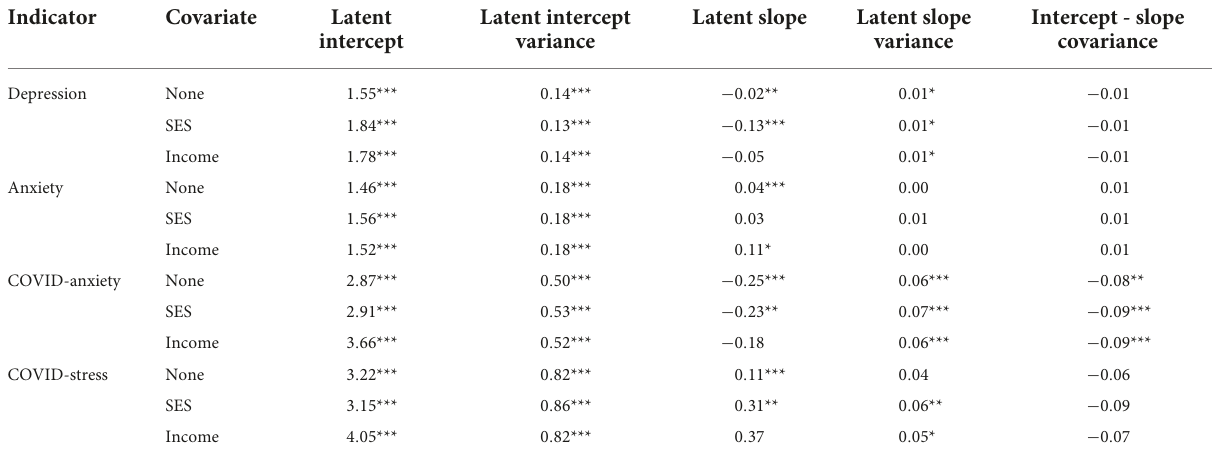
TABLE 3 Results of the linear growth models.